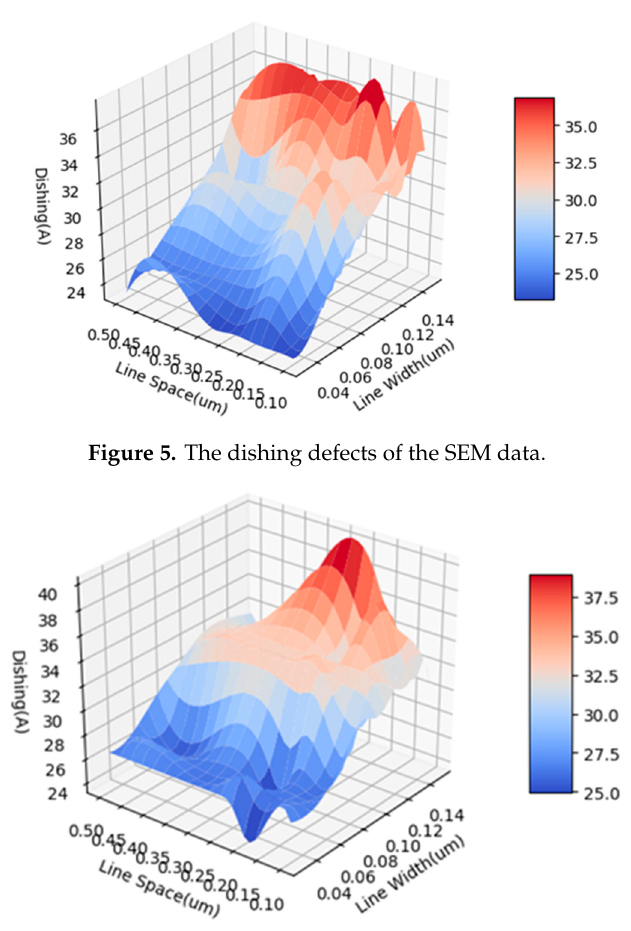
Figure 7. The dishing defects of the predictions of the common NN-based CMP model. The RMSE is 3.56 A.